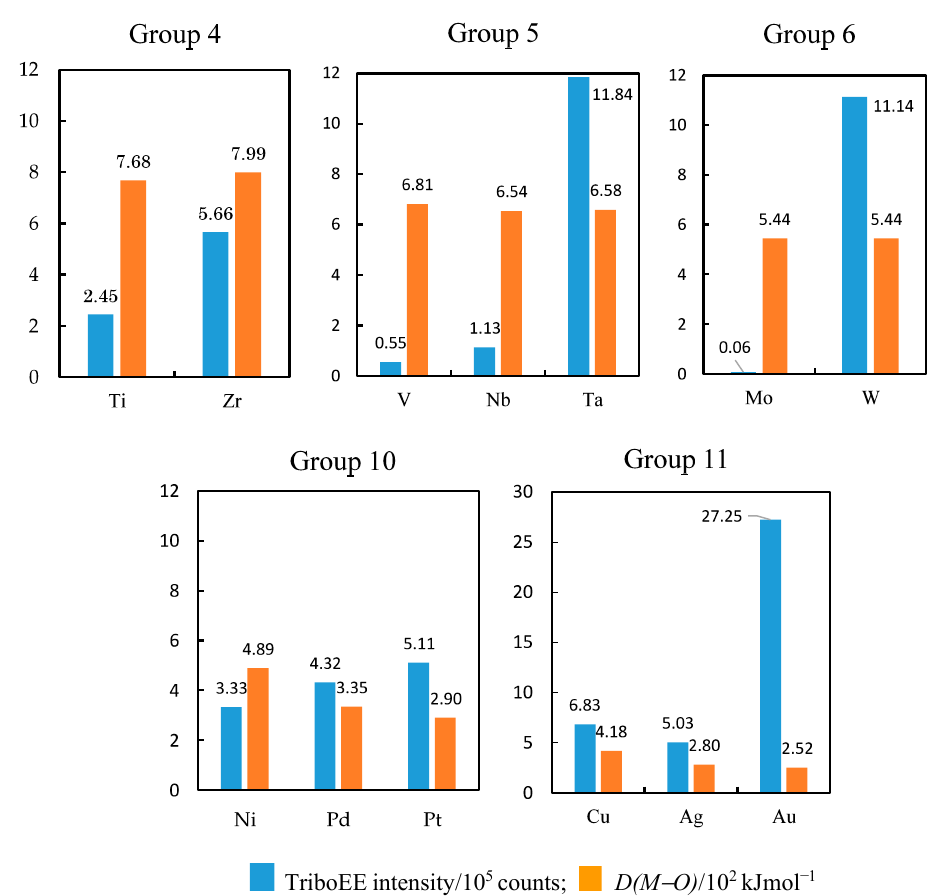
Figure 9. The relationship between the TriboEE intensity and the D(M–O ) values for metals in groups 4, 5, 6, 10, and 11.